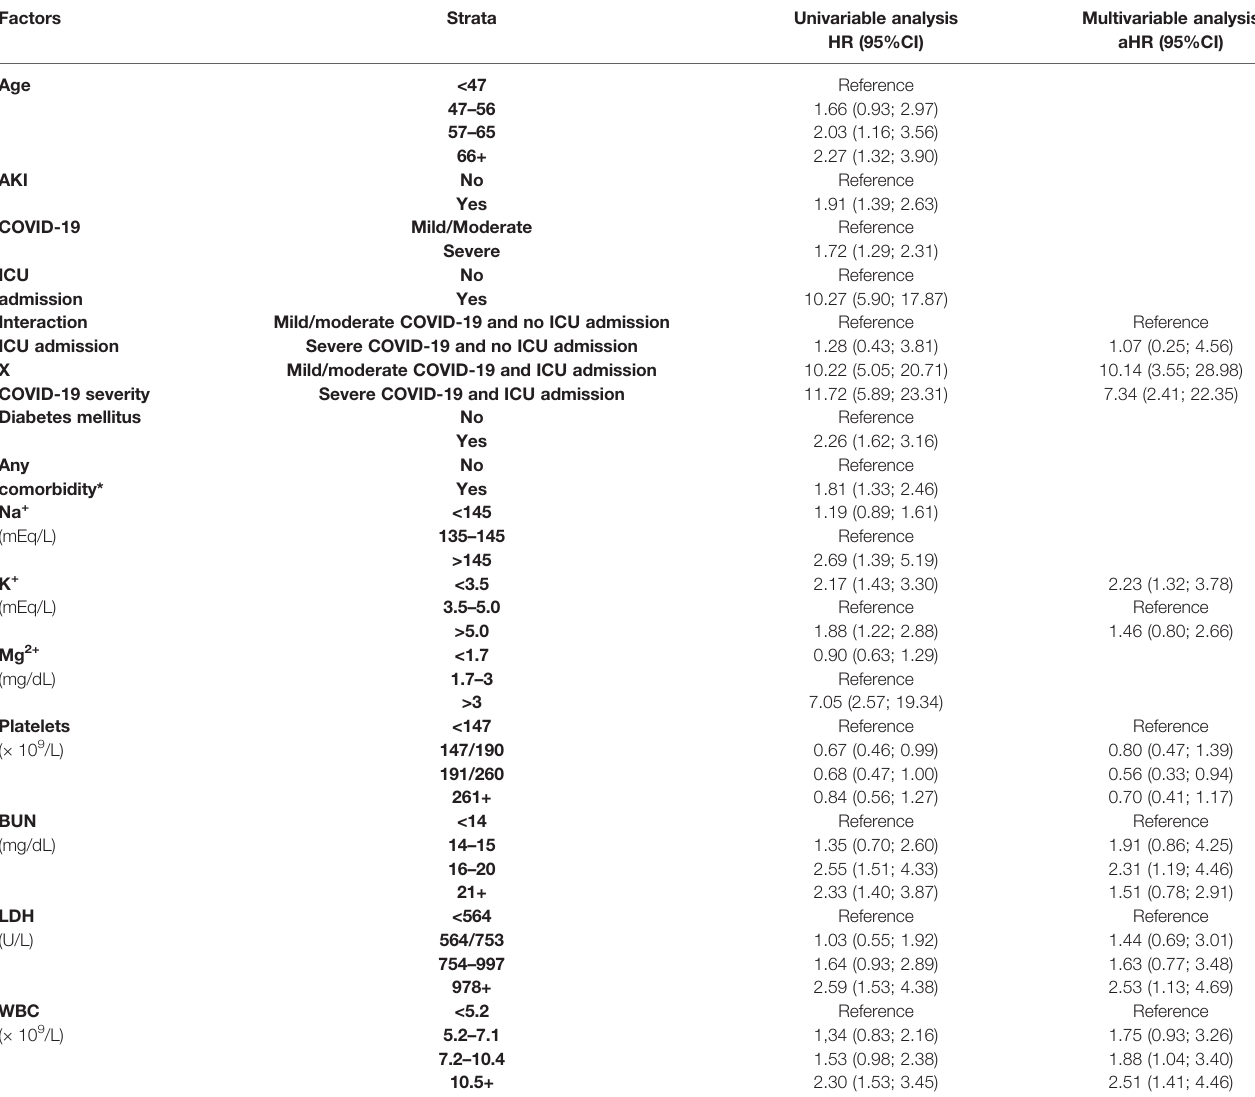
TABLE 5 | Multiple Cox regression model on the risk of